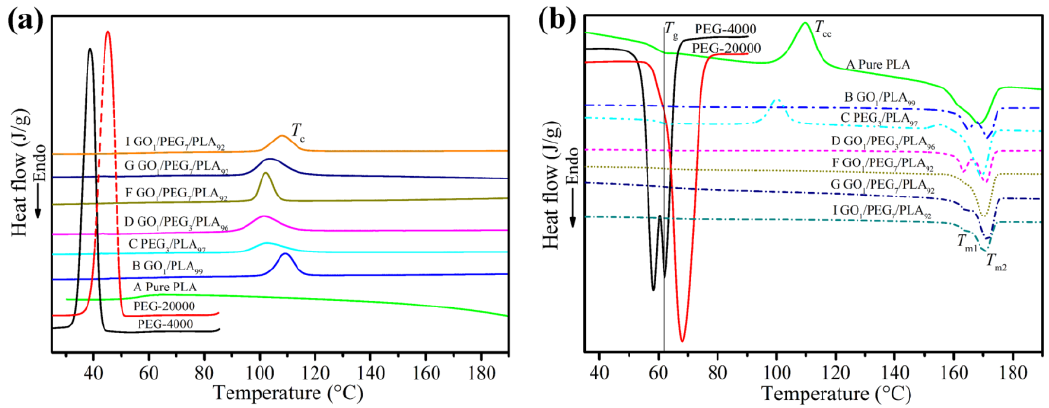
Figure 7. Differential scanning calorimetry (DSC) curves of PEG, pure PLA, GO/PLA, PEG/PLA, and GO/PEG/PLA multi-phase composites with different component ratio under different melt-compounding. ( a ) Cooling curves; ( b ) melting curves. Table 4. Thermal properties of PLA-based composites as a function of different GO/PEG. Samples